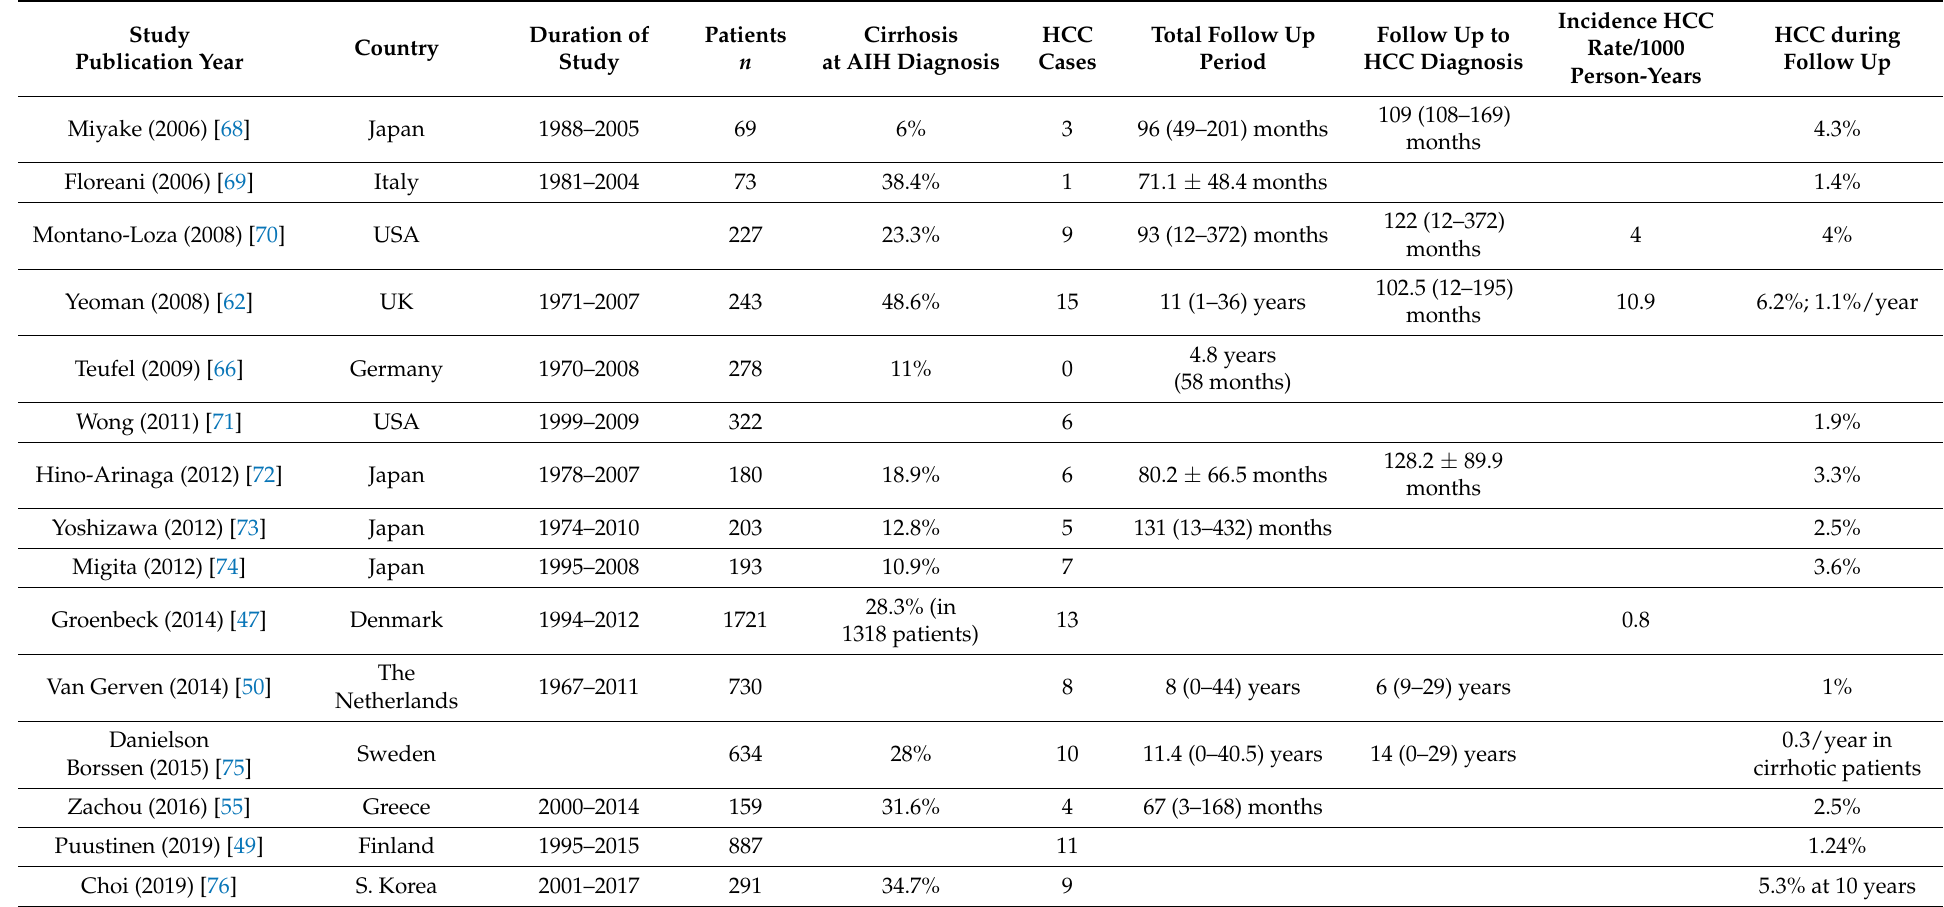
Table 1. Incidence of hepatocellular carcinoma (HCC) in patients with autoimmune hepatitis